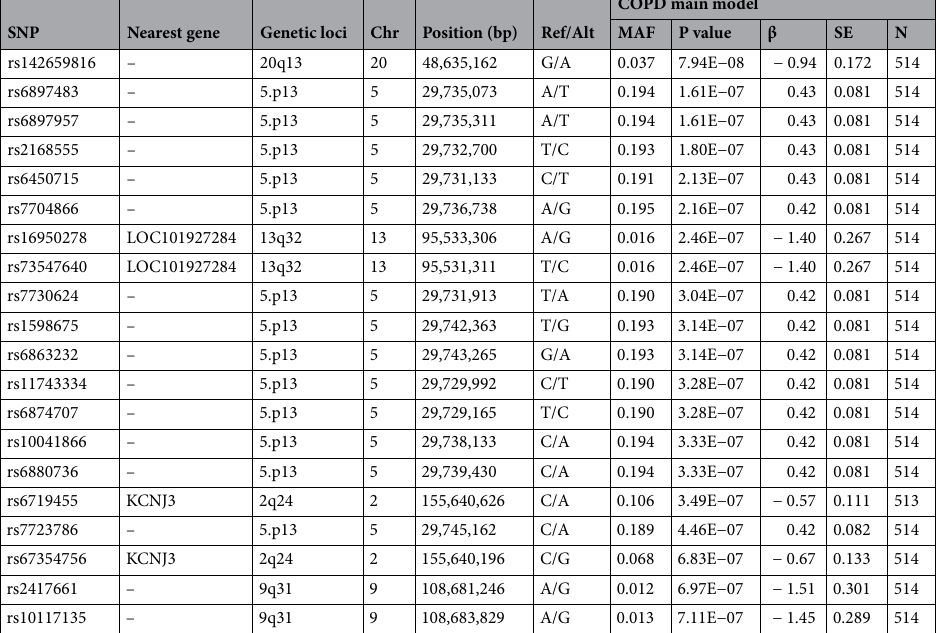
Table 3. Top 20 SNPs of GWAS results in COPD patients for emphysema. Model 1 was adjusted for Center, Age, Sex, Smoking event and Pack-years. COPD chronic obstructive pulmonary disease, LNEI natural